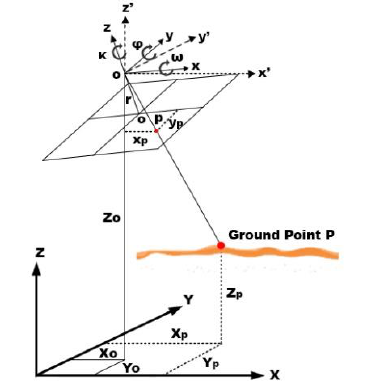
Figure 10. Illustration of space resection in photogrammetry (Mikhail et al., 2001)